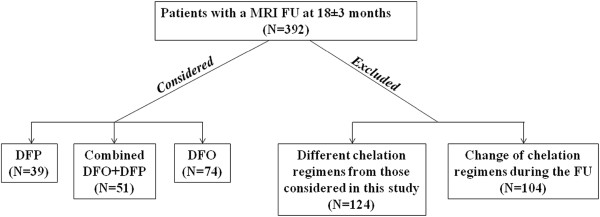
The patient flow.